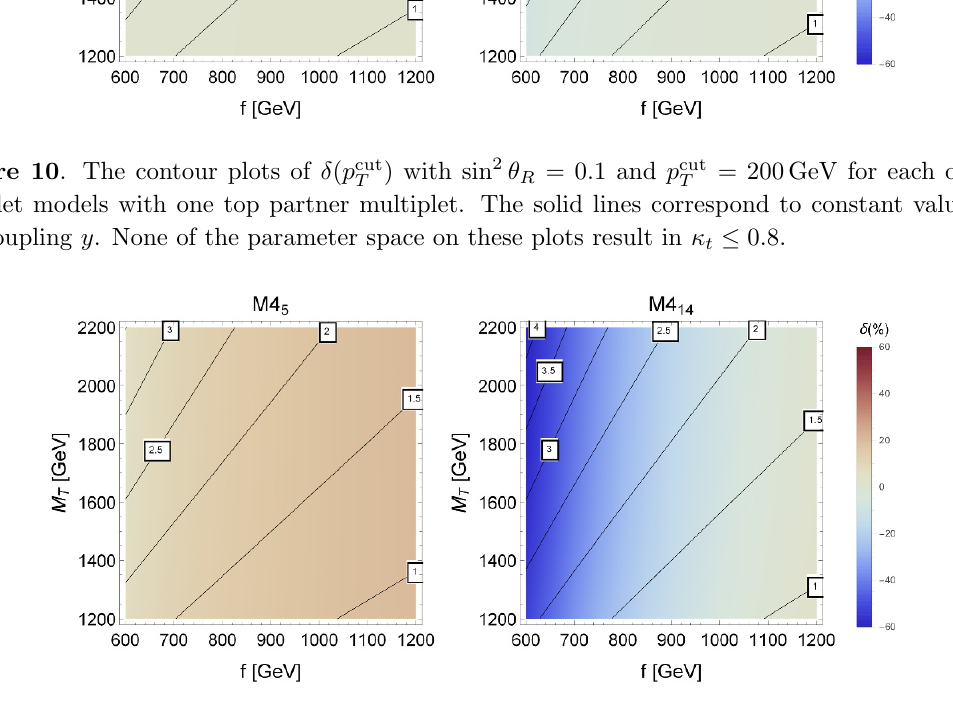
Contour plots with p cut